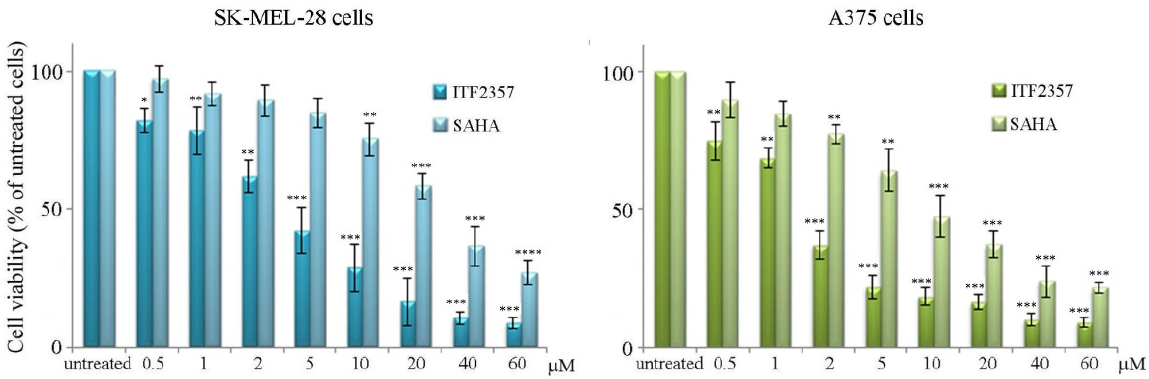
Figure 1. The effects of ITF2357 and SAHA on melanoma cell viability. For the evaluation of cell viability, SK-MEL-28 and A375 cells were treated with the indicated concentrations of ITF2357 or SAHA for 48 h. MTT analysis was then carried out as reported in Materials and Methods. The results reported in the histograms are representative of three independent experiments. * p < 0.05, ** p < 0.01, *** p < 0.001, **** p < 0.0001 with respect to untreated cells.